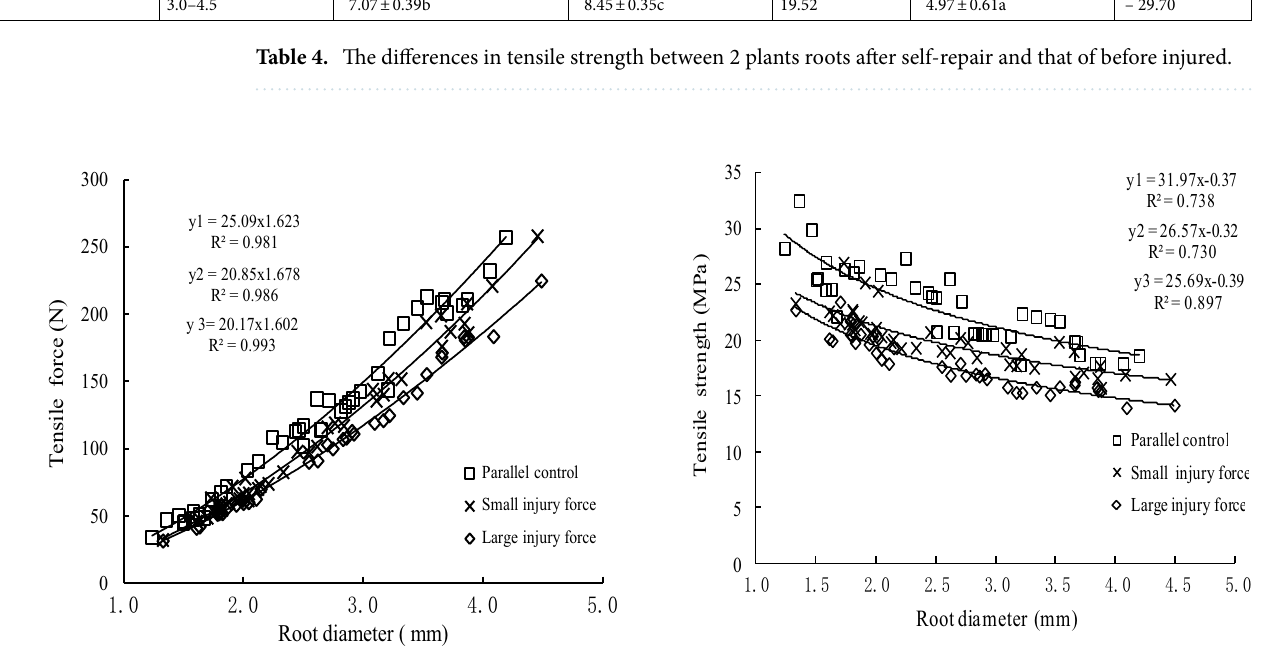
Figure 6. The differences in tensile ability between Salix psammophila roots after self-repair and parallel control